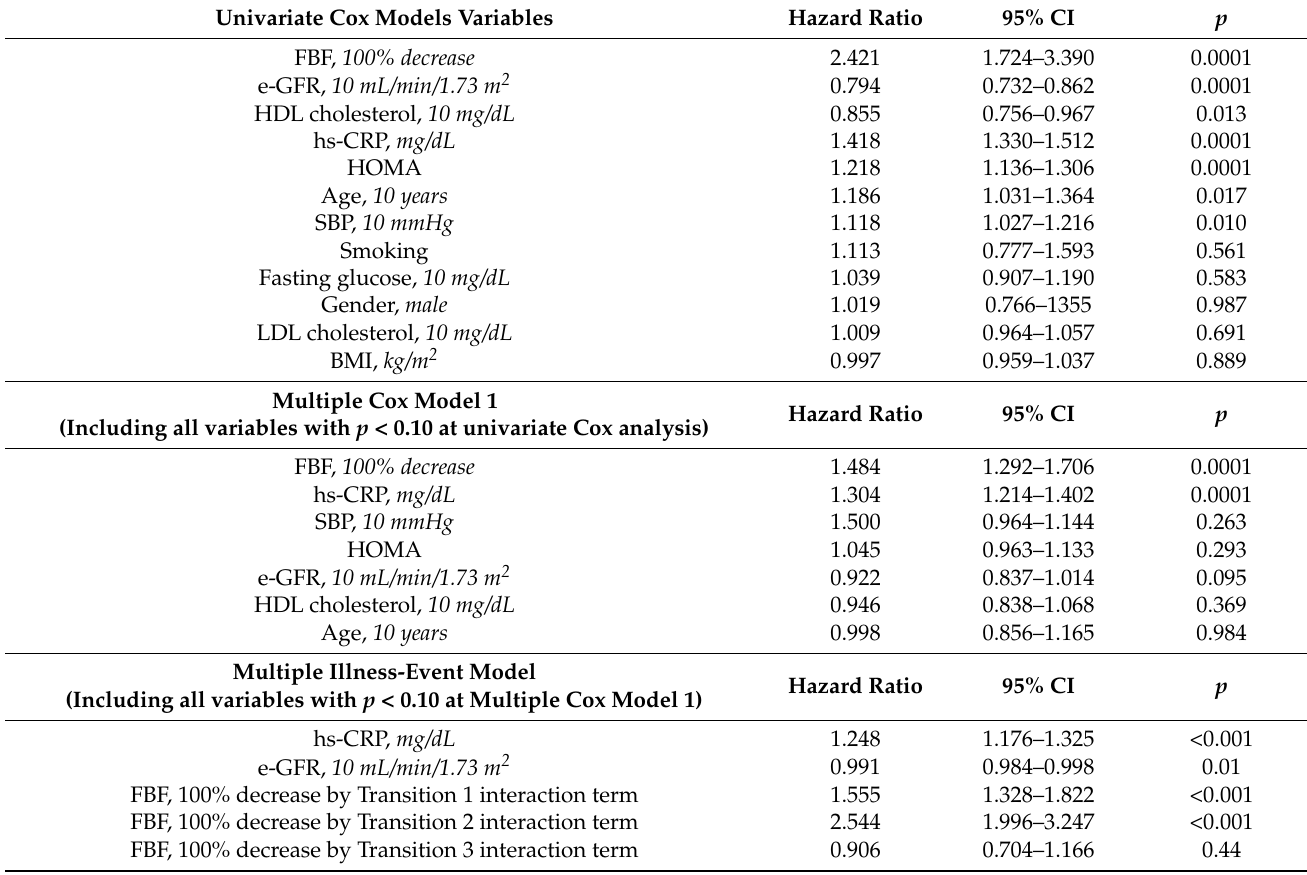
Table 2. Cox regression and illness events analyses for incident cardiovascular